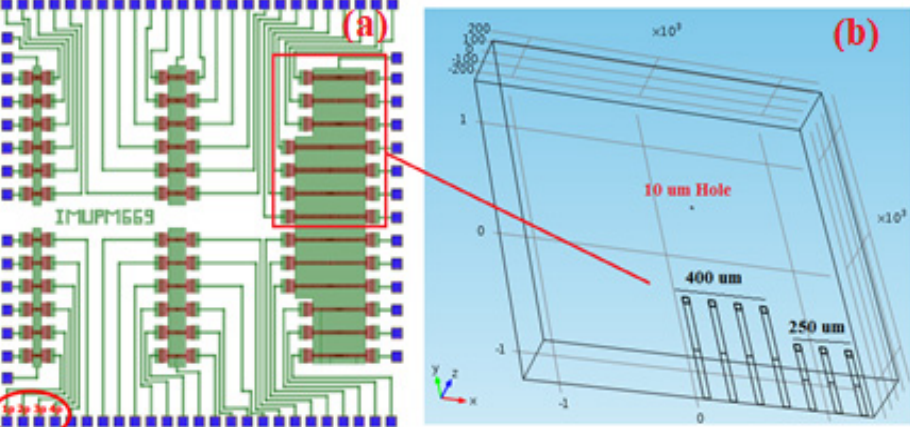
Figure 4. ( a ) The layout of the microcantilevers chip. ( b ) The simulated 3D model of the sensor chip. A 10 µm hole is used to direct airflow into the chip while it was 400 µm above the upper surface of the chip. This figure represents the computational domain, which is exactly as same as the real sensor. For AbFM systems, after drawing the layout of the sensor, a 3D scheme of the sensor will be designed for fluid–solid interaction analysis under air pressure loads.